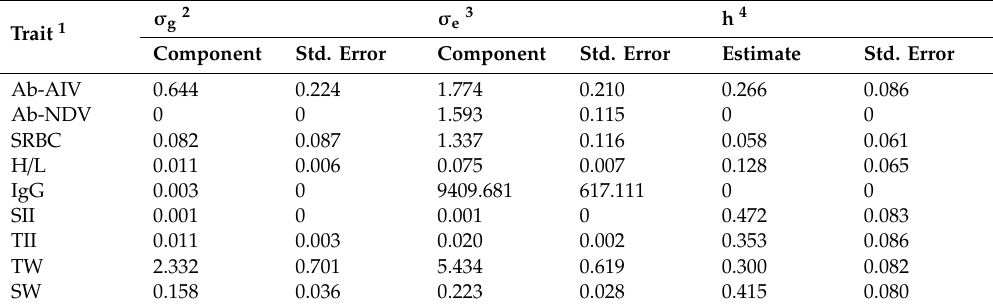
Table 3. Genetic parameters estimated from all data with the genetic linear unbiased prediction of genomes (GBLUP) model.